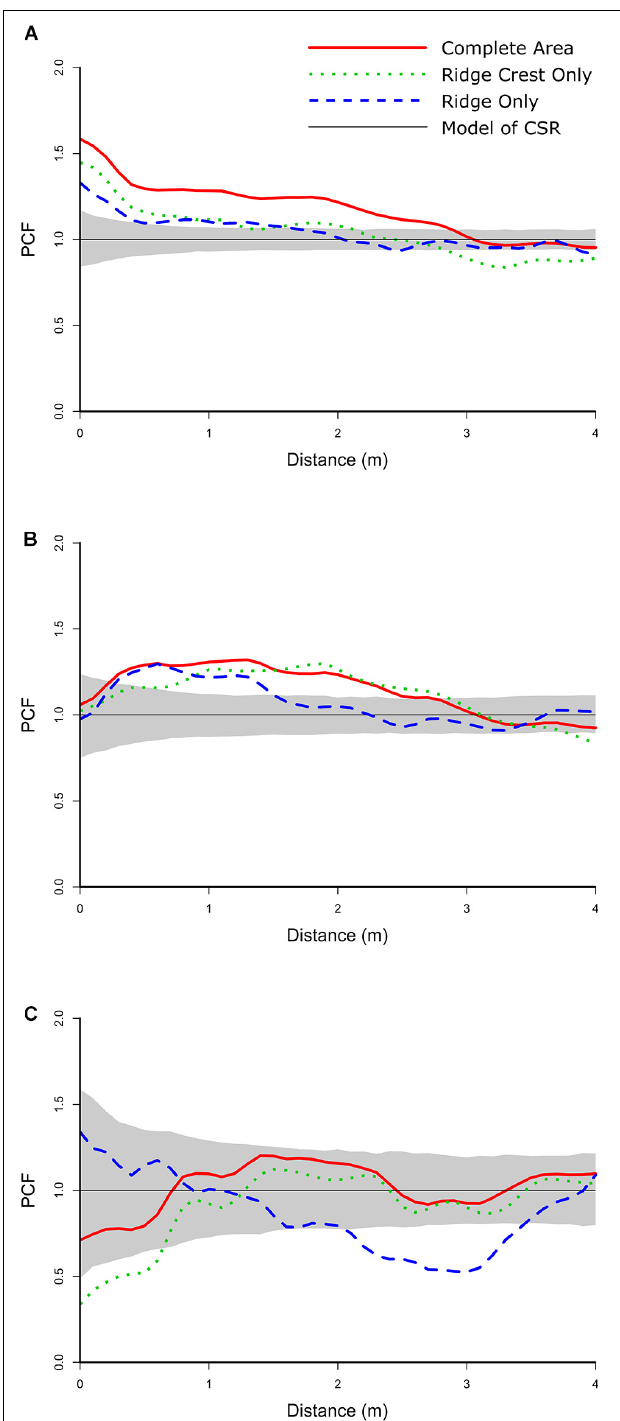
FIGURE 7 | Bivariate PCF analyses for the taxa with non-independent spatial distributions. The gray area is the simulation envelope of complete spatial randomness (CSR) for 999 Monte Carlo simulations. The x -axis is the inter-point distance between organisms in meters. On the y -axis, PCF = 1 indicates CSR and is indicated by a black line, < 1 indicates segregation, and > 1 indicates aggregation. (A) N. bowersi – Aspidoscopulia. (B) N. bowersi – Advhena magnifica. (C) N. bowersi—N.